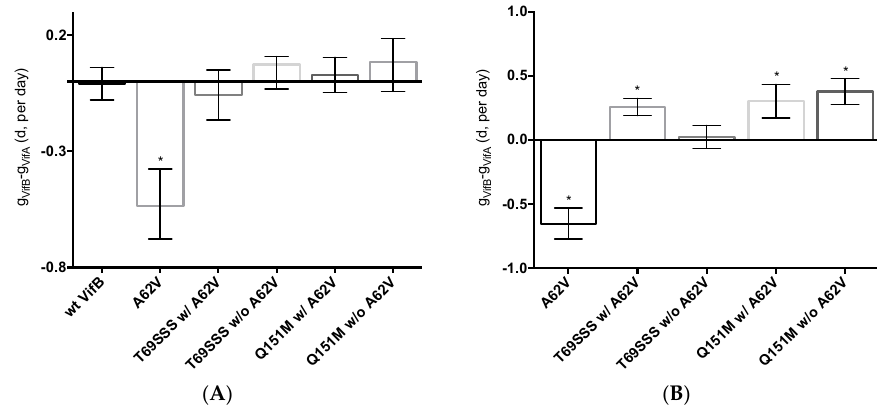
Figure 5. Dual-competition virus fitness assay of multi-drug-resistant HIV-1 mutants in the presence or absence of A62V. The net growth rate difference ( d ) of multi-dideoxynucleoside resistant (MDR) HIV-1 mutants (with or without A62V), in the absence ( A ) or presence ( B ) of AZT, was determined using the difference between the growth rate of wt HIV-1 (vifB) and mutant (vifA), that is, g VifB − g VifA . To assess the replication fitness, a real-time TaqMan PCR assay was used to monitor and differentiate between the mutant and parental virus using polymorphisms in the vif gene. All growth difference values (i.e., panels A , B ) were set relative to no-AZT wt HIV-1 ( vifB ), shown in panel ( A ) . The polymorphisms in the vif gene had a small fitness impact, as shown in panel ( A) ; this effect was taken into consideration for all calculations. The wt HIV-1 ( vifB ) was not directly included in panel ( B ) due to inability to replicate it in the presence of AZT. Reported are the means and 95% confidence intervals (CIs) from triplicate competition experiments. The asterisk (*) indicates a significant difference ( p -value < 0.05, calculated using methods explained elsewhere [30]) relative to the corresponding vif gene polymorphisms ( vifA , mutant virus; vifB , parental virus).